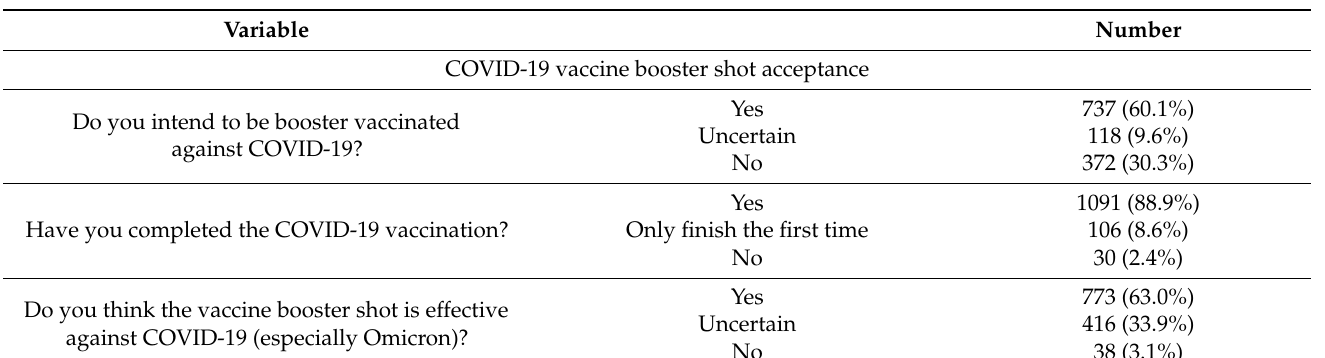
Table 2. Summarized findings on the acceptance of vaccine booster shots among employees in H